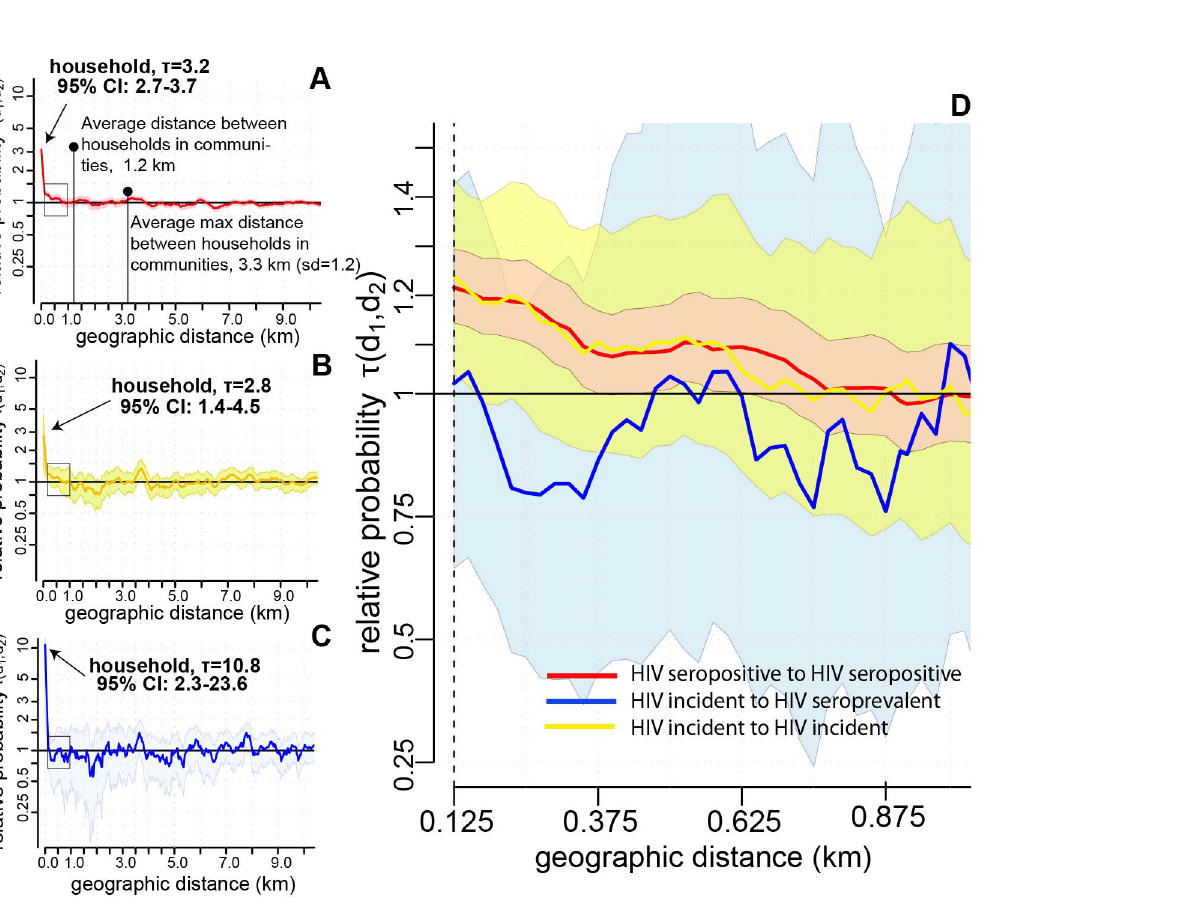
Figure 2. Spatial clustering of HIV-seropositive persons within households (0 km) and in geographic windows of 250 m up to 10 km (the first window is 10–250 m, and windows are centered every 50 m starting at 125 m). Spatial clustering analyses show whether HIV prevalence or incidence is elevated within certain distances of other HIV-seropositive persons. We define the spatial clustering of HIV-seropositive individuals as t ( d 1 , d 2 ), the relative probability that an HIV-seropositive person resides within a distance window, d 1 to d 2 , from another HIV- seropositive person compared to the probability that any individual is HIV seropositive in the entire study population. Where spatial clustering exists, values of t ( d 1 , d 2 ) exceed one. Shaded areas show the 95% bootstrapped confidence intervals for spatial clustering estimates. (A) The spatial clustering between HIV-seropositive persons (prevalent or incident cases with other prevalent or incident cases; red). (B) The spatial clustering of HIV- seroincident cases with ART-naı¨ve HIV-seroprevalent persons (yellow). (C) The spatial clustering of HIV-seroincident cases with other HIV-seroincident cases (blue). (D) A blowup of the area where significant extra-household spatial clustering ( , 500 m) was identified among all HIV-seropositive persons (marked with black box in [A–C]). Data are shown only up to 10 km (no significant spatial clustering was observed beyond this